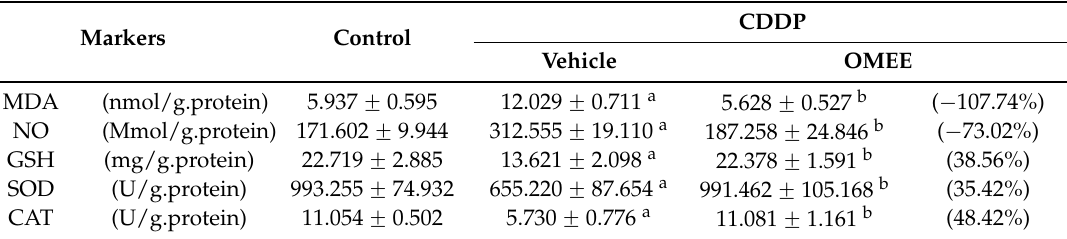
Table 2. Effect of OMEE on CDDP ‐ induced oxidative/nitrosative damage.